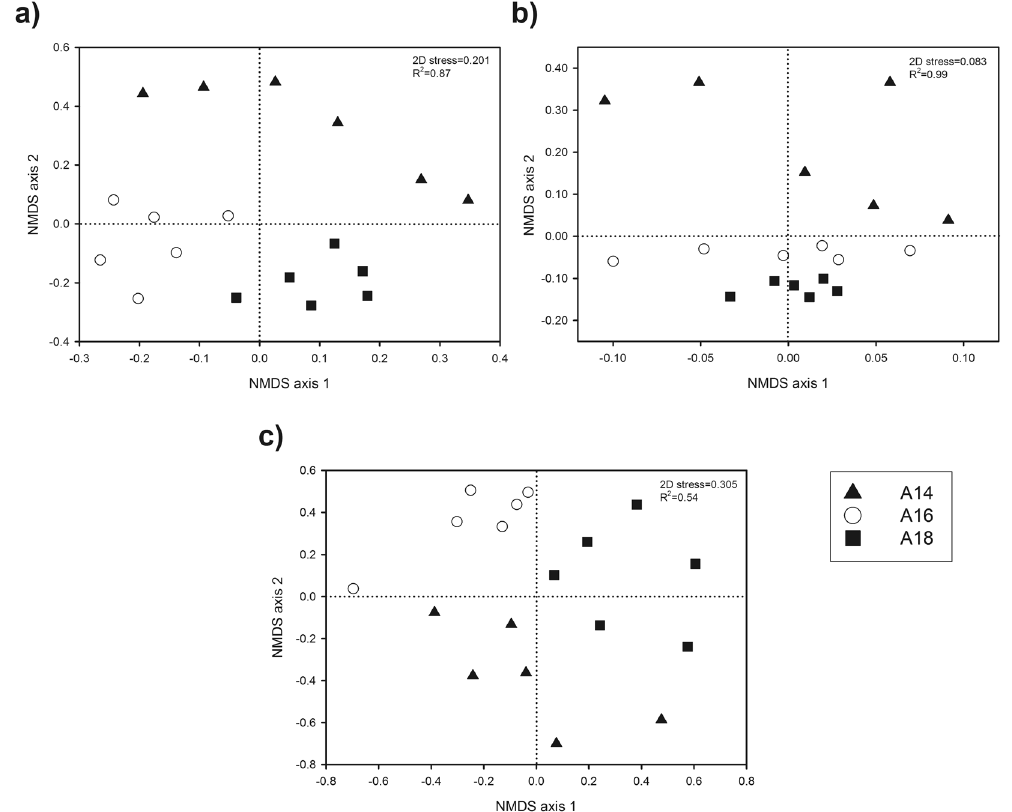
Figure 3. Non-metric multidimensional scaling (NMDS) ordinations based on Bray-Curtis similarities of OTU-based bacterial ( a ), archaeal ( b ) and fungal ( c ) community structures found in the layers A14 (upper), A16 (intermediate) and A18